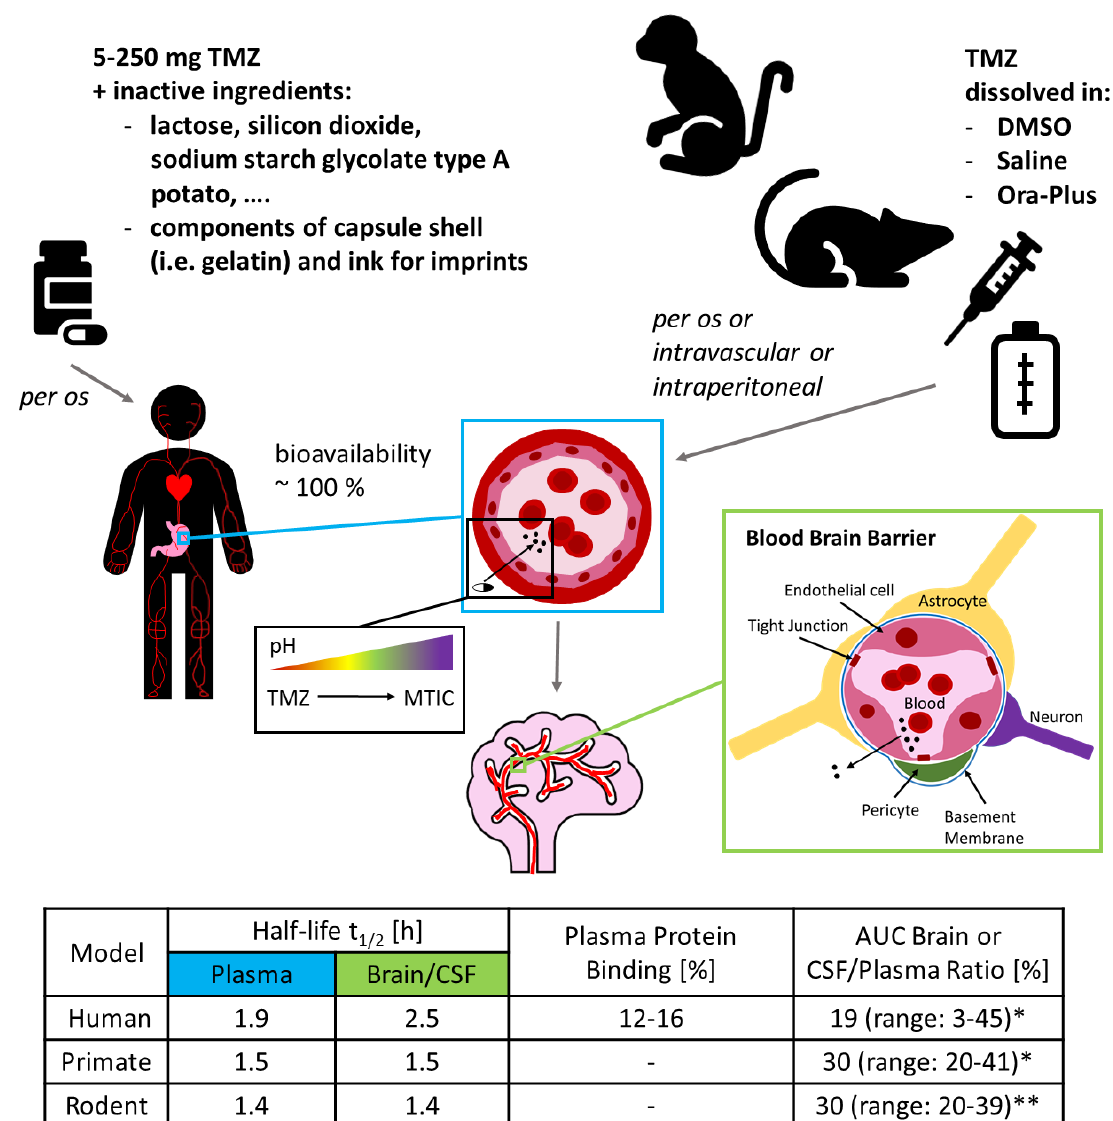
Figure 1. Pharmacokinetic features of Temozolomide (TMZ) and di ff erences among species. This figure depicts key pharmacokinetic data from humans and experimental animal models. Model according to [15]. Information on clinical grade TMZ see package insert (URL: https: // www.msd.de / fileadmin / files / fachinformationen / temodal_hartkapseln.pdf, link accessed on 29 May 2020). Information on TMZ for animal experiments see [20,41–45]. Table according to [31,33–35,40,46–53]. Dash) data not reported; (*) range of absolute area under the curve (AUC) brain or cerebrospinal fluid (CSF) / plasma ratio; (**) range of mean AUC brain or CSF / plasma